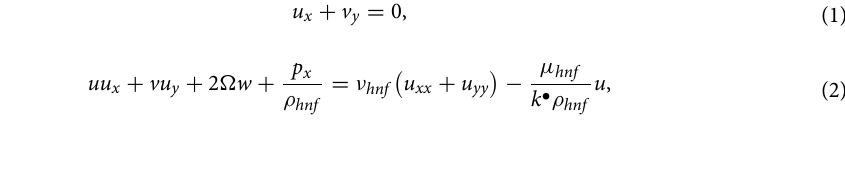
Table 1. Physical and thermal characteristics of water (working liquid), Graphene, Ag, and CuO (nanomaterials) 42–47 .